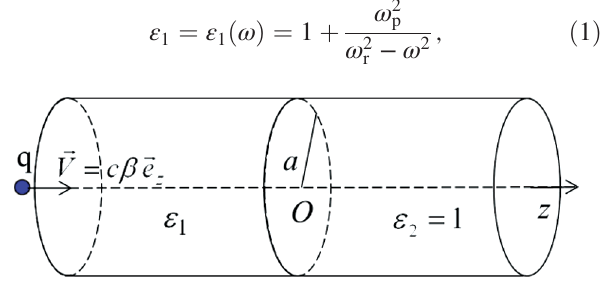
FIG. 1. Geometry of the